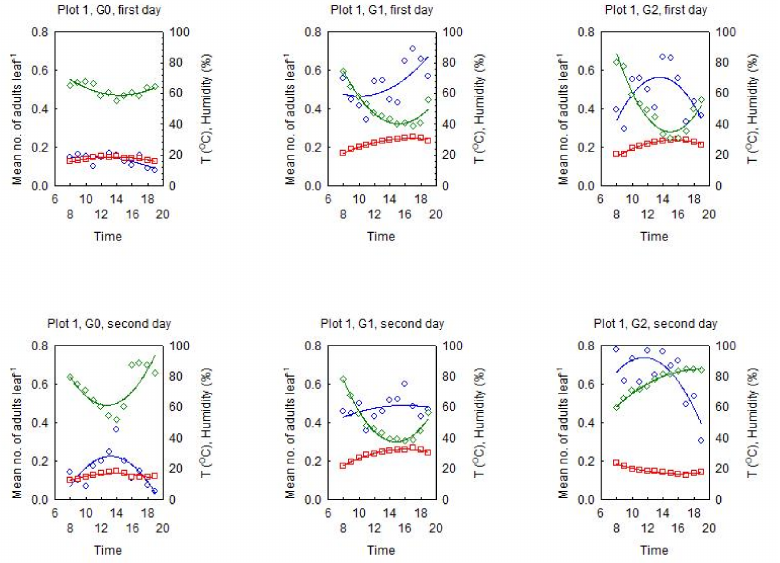
Figure 3. Dynamics of the diurnal activity of the OLB population in Plot 1 (S tering population; G1 = first generation; G2 = second generation; blue = number of adults in flight; green = relative air humidity; red = air temperature.